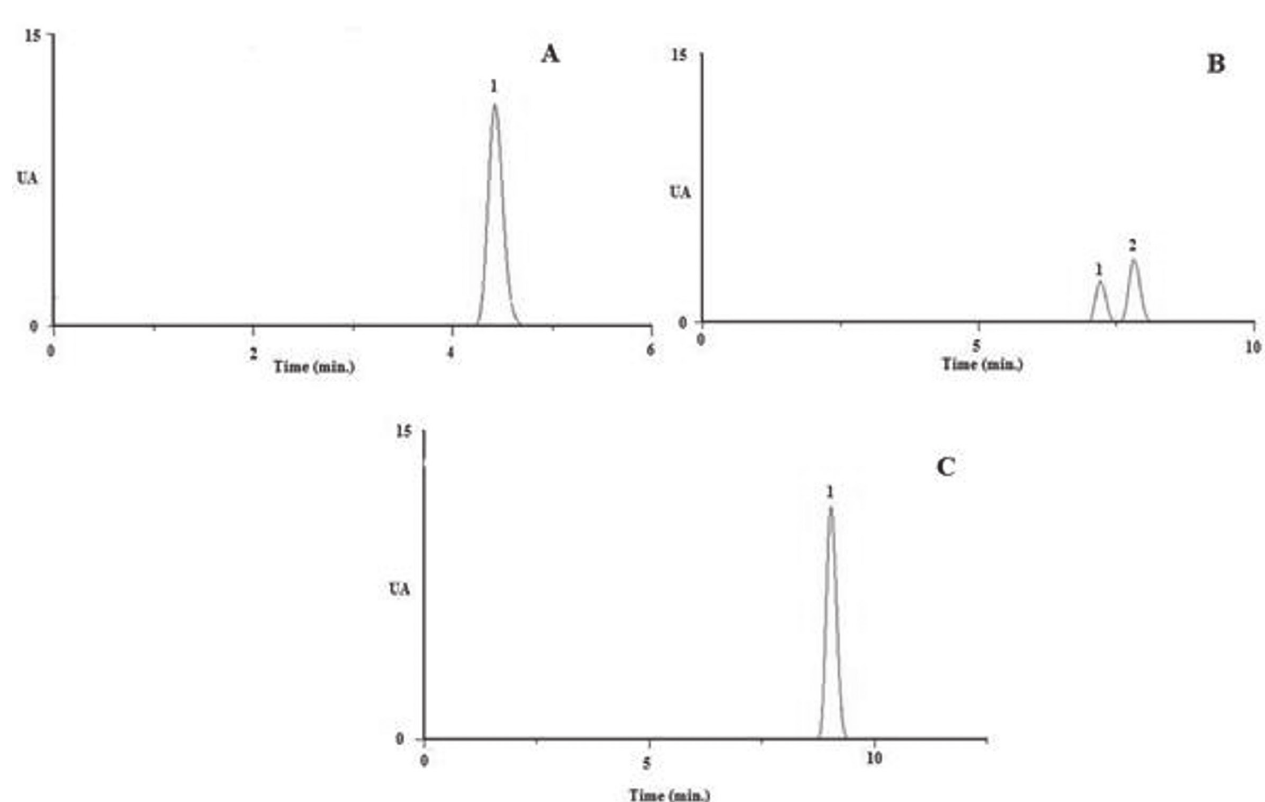
FIGURE 6 - Chromatograms of active substances, benzophenone-3 (BP-3) (A), ethylhexylmethoxycrylene (EHMCR cis and trans isomers) (B) and octyl- p -methoxycinnamate (OMC) (C), at 15 μg.mL -1 each. Chromatographic conditions: Gilson equipment (Shimadzu, Canby, OR, USA); Gilson Unipoint 3.0 software system controller (Gilson, Bedfordshire, UK); reverse-phase column (C18); 320 nm; 40 o C; acetonitrile:water (90:10) and 1.0 mL.min -1 .